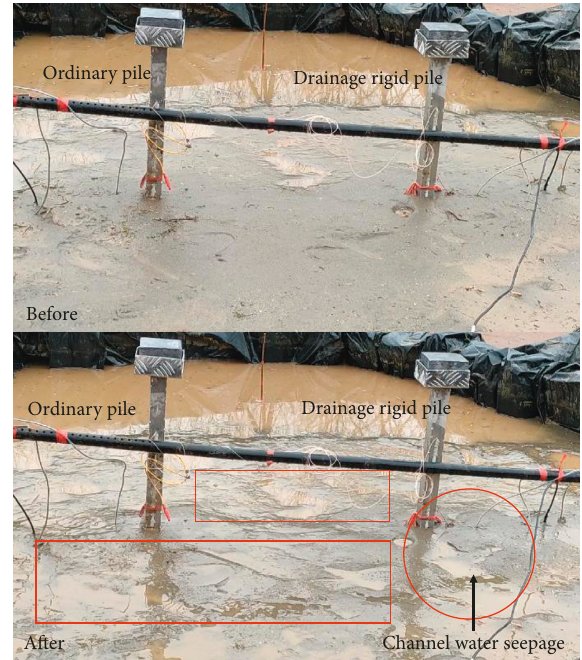
Figure 8: Comparison chart before and after multiple fracturing blast vibration tests.